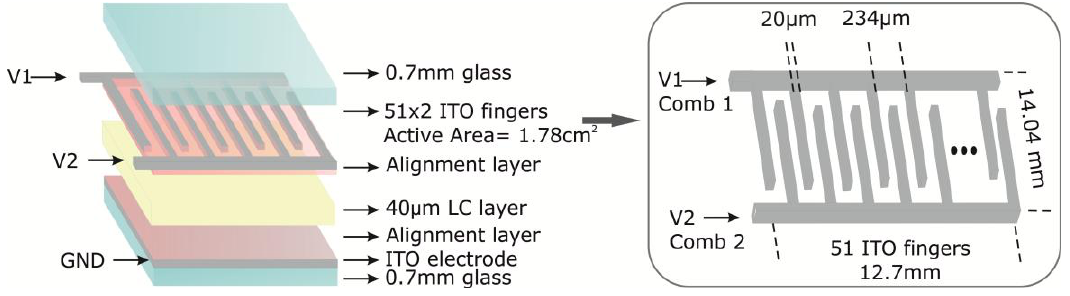
Figure 2. Liquid crystal temperature sensor. ( a ) Three dimensional (3D) diagram and ( b )